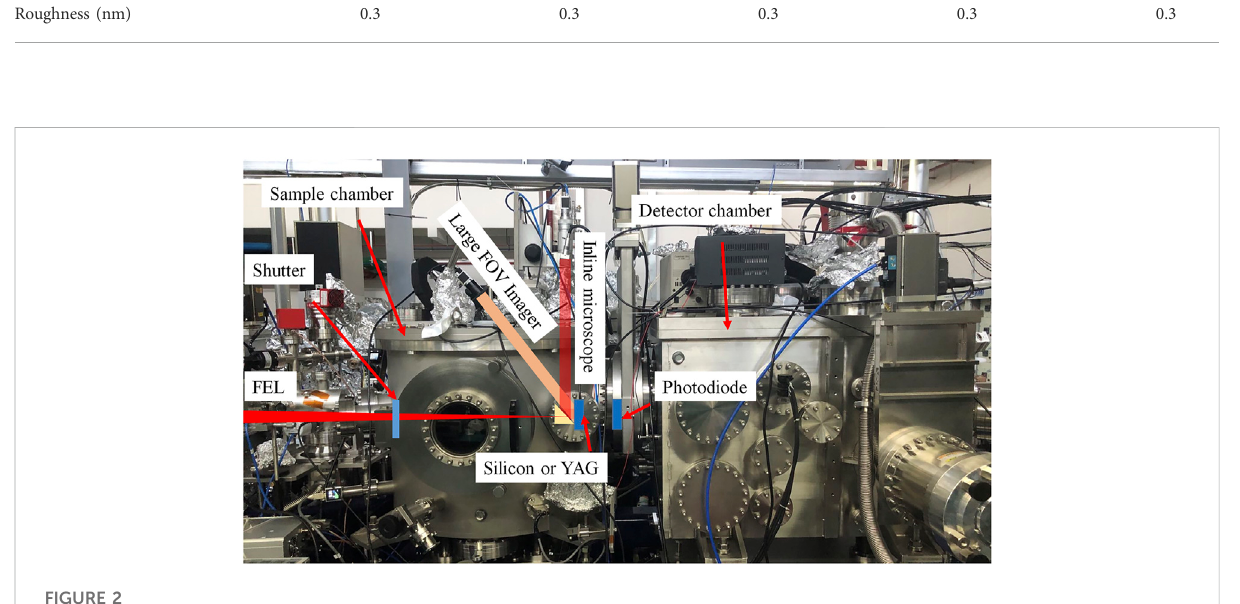
FIGURE 2 Photo of the CSI